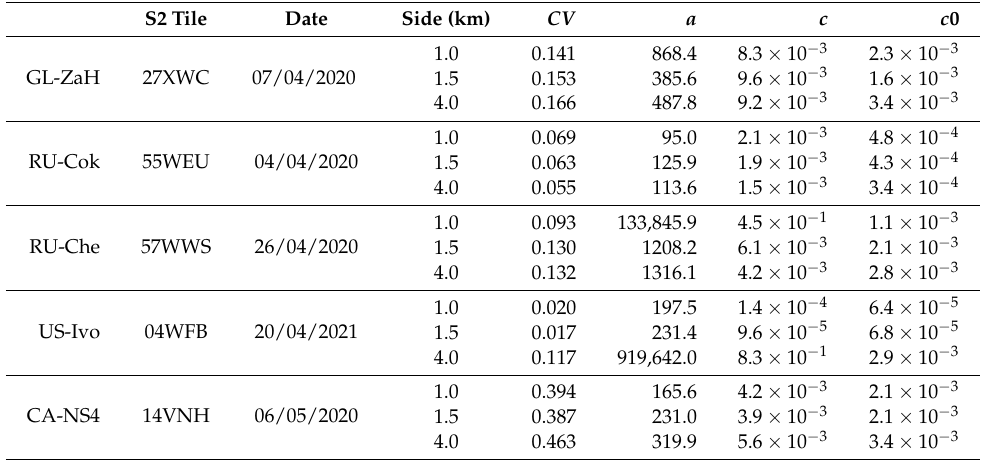
Table 3. Variogram paramters derived from snow-covered S2 MSI L2A shortwave reflectance images around each station. CV = coefficient of variation, a = range, c 0 = nugget, c = partial sill. S2